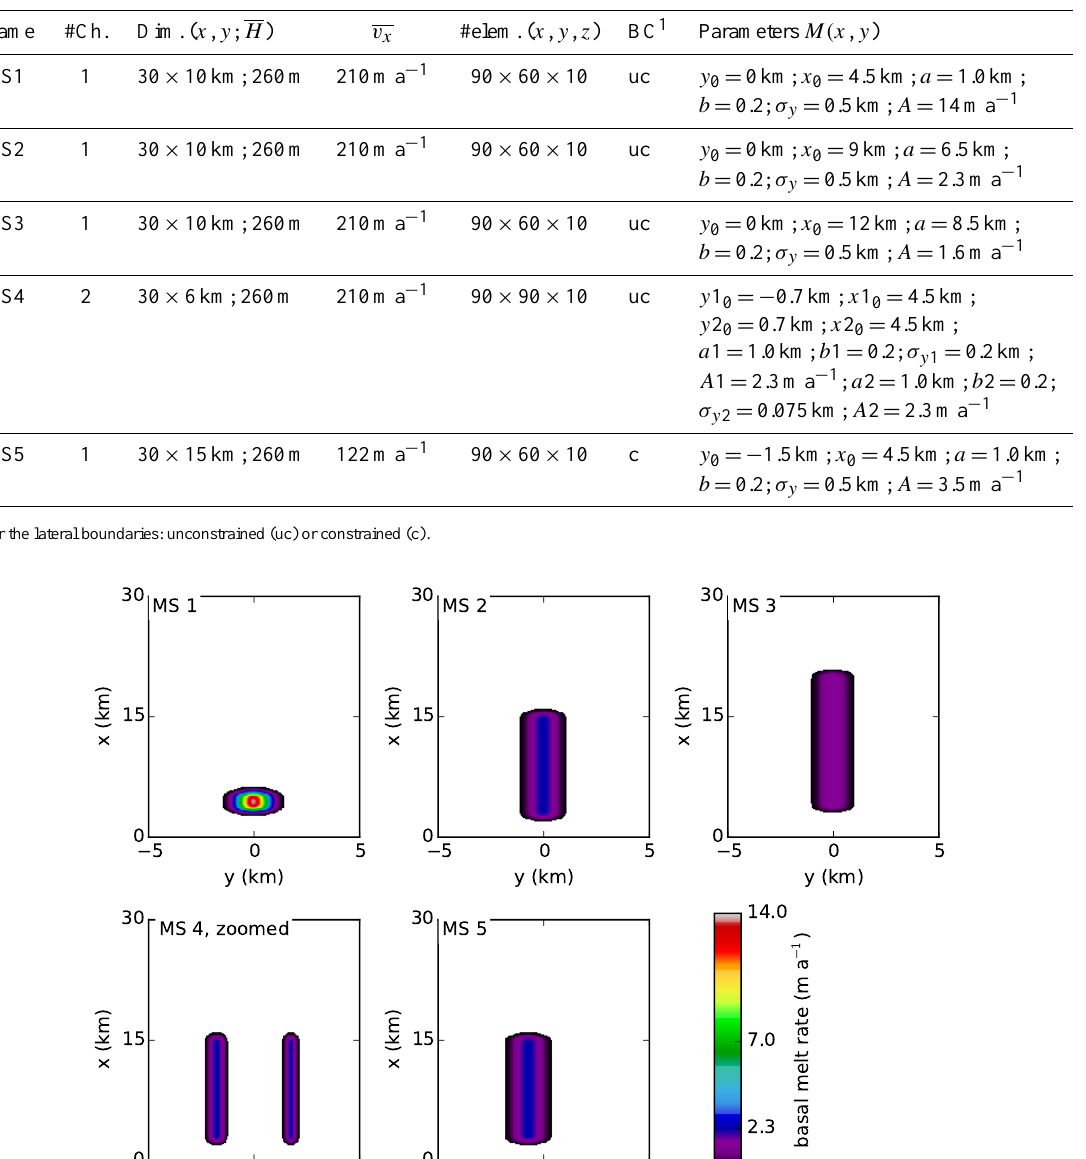
The forced hydrostatic equilibrium at the landward bound- ary saves computation time, but is unphysical because grounding lines are typically not in hydrostatic equilibrium et al., 2011). The applied simplifications cause small hydro-